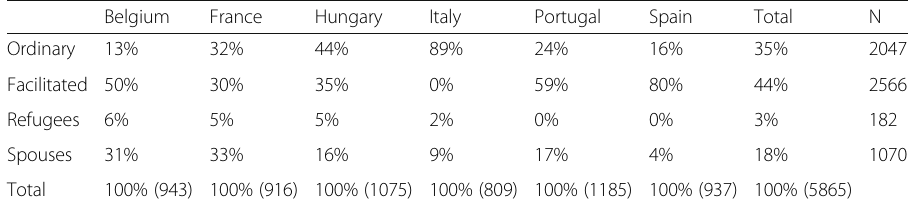
Table 2 Eligibility for nationality laws and procedures: Respondents by category